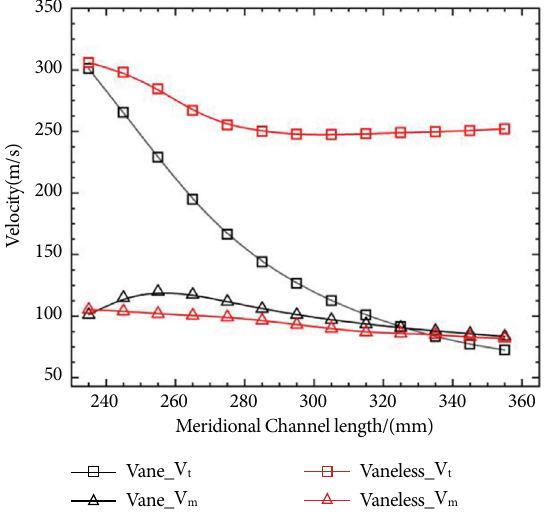
Figure 8: Velocity distributions of vaned and vaneless di ff